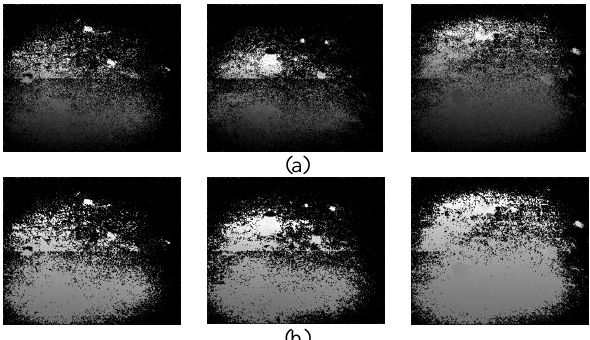
Figure 4. (a) Initial depth images (b) depth images after enhancement